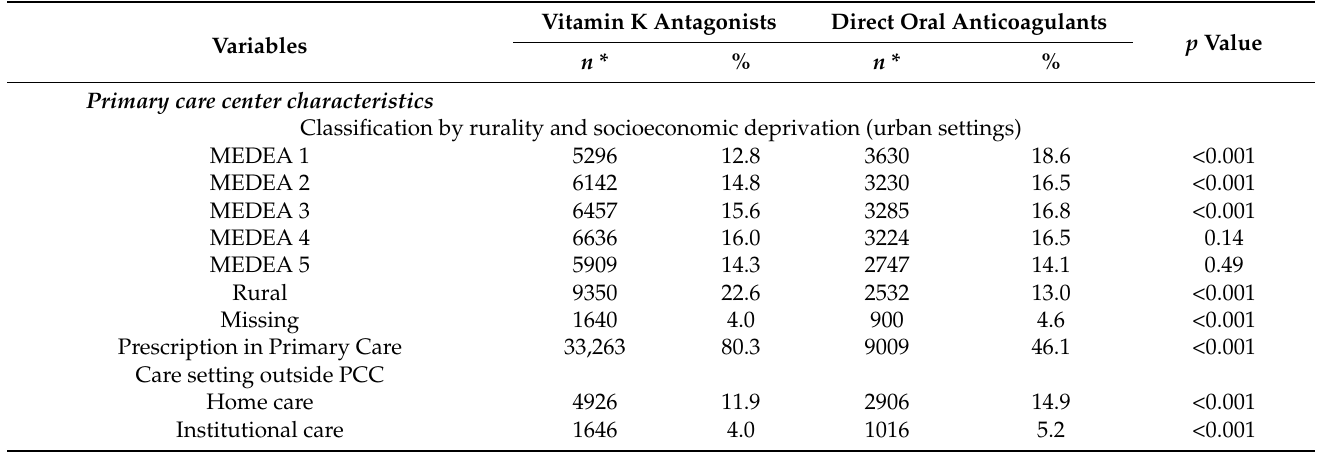
Table 1. Description of patient population according to class of oral anticoagulants prescribed.